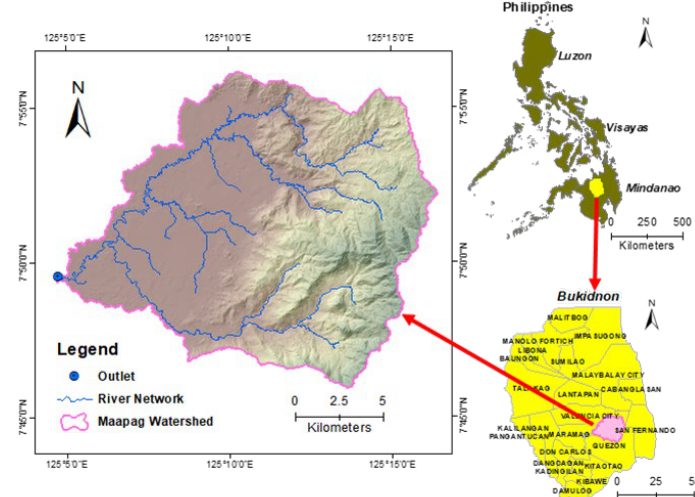
Fig. 1: Geographic location of the study area in Maapag Watershed, Valencia City of Bukidnon, Mindanao, Philippines